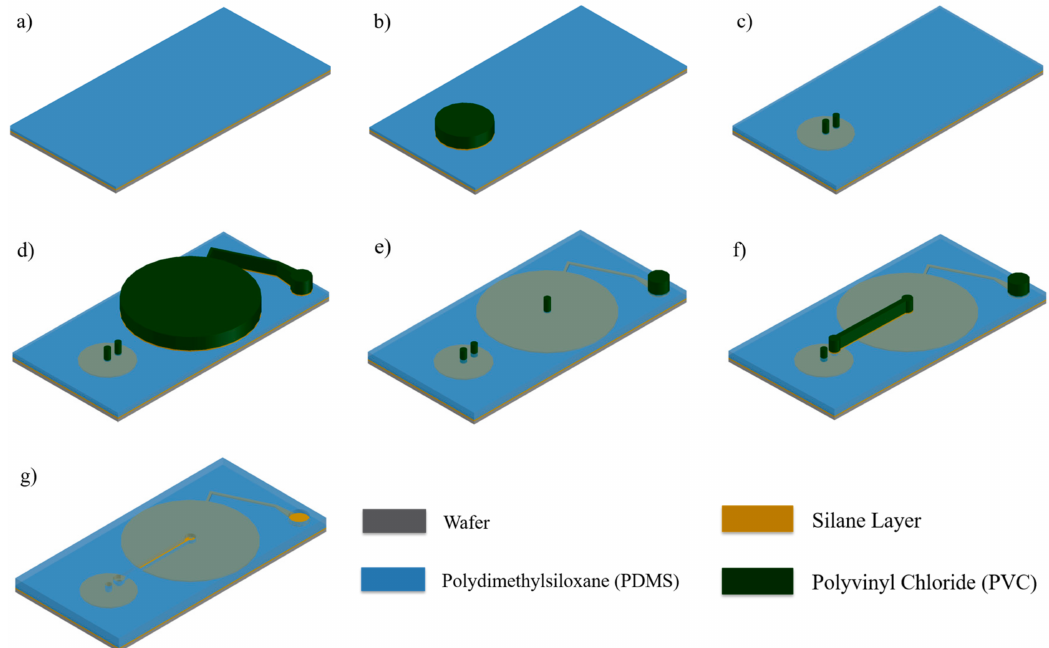
Figure 3. Inflatable/deflatable chamber fabrication steps. ( a ) Spin coating PDMS on silanized wafer. ( b ) Paste secondary chamber stencil on silanized PDMS and treat with oxygen plasma. ( c ) Remove chamber portion of the stencil leaving the inlet and outlet stencils. Then, spin coat PDMS. ( d ) Paste primary reservoir stencil on silanized PDMS and treat with oxygen plasma. ( e ) Remove chamber portion leaving the inlet and outlet stencils. Then, spin coat PDMS. ( f ) Align and paste microchannel stencil on silanized PDMS and treat with oxygen plasma. ( g ) Finally, spin coat PDMS and cure. Remove remaining stencils leaving three holes: inlet, outlet and microchannel. Yellow portions depict the detached area. In other words, the detached area illustrates the inflating and deflating